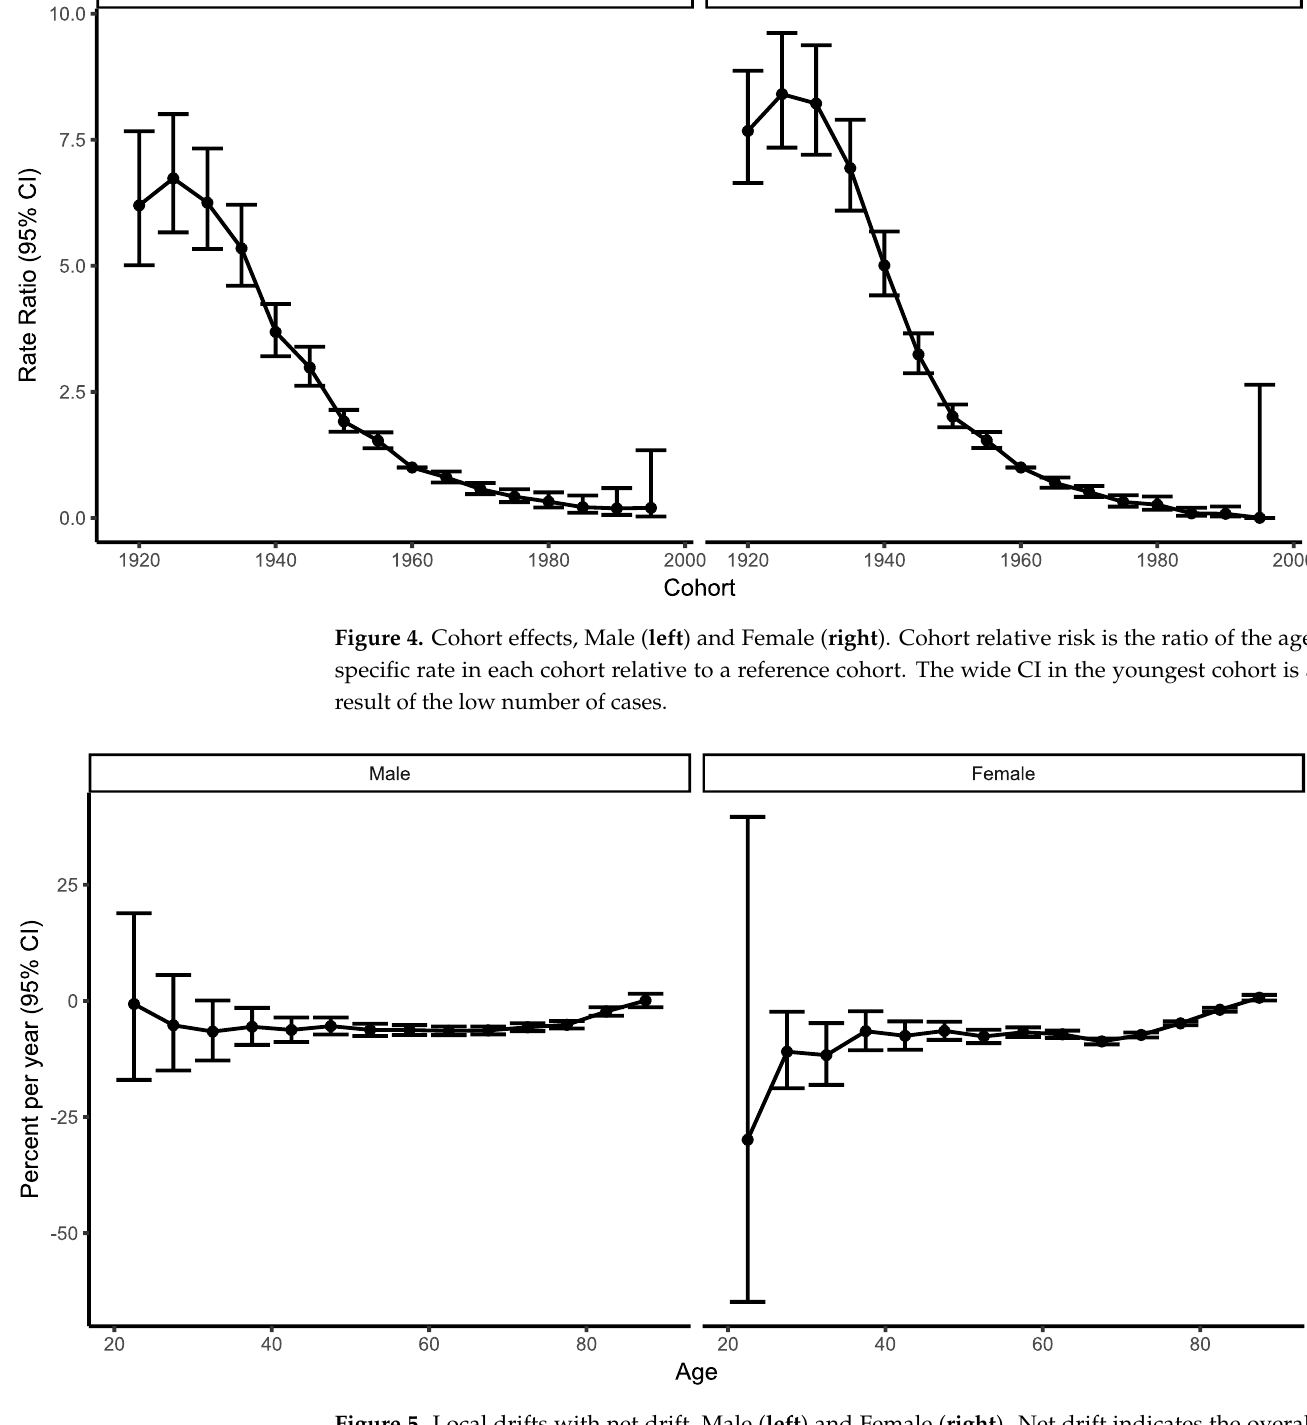
Figure 5. Local drifts with net drift, Male ( left ) and Female ( right ). Net drift indicates the overall annual percentage change across the whole study period. Local drift indicates the annual percentage changes in mortality rate for each age group relative to the net drift.